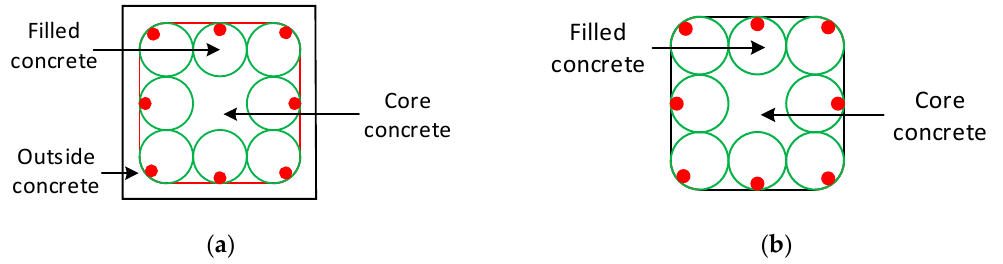
Figure 2. Cross-sections of the encased fiber reinforced polymer confined concrete cores (EFCCC) columns: ( a ) specimen T8 and ( b ) specimen T8N.